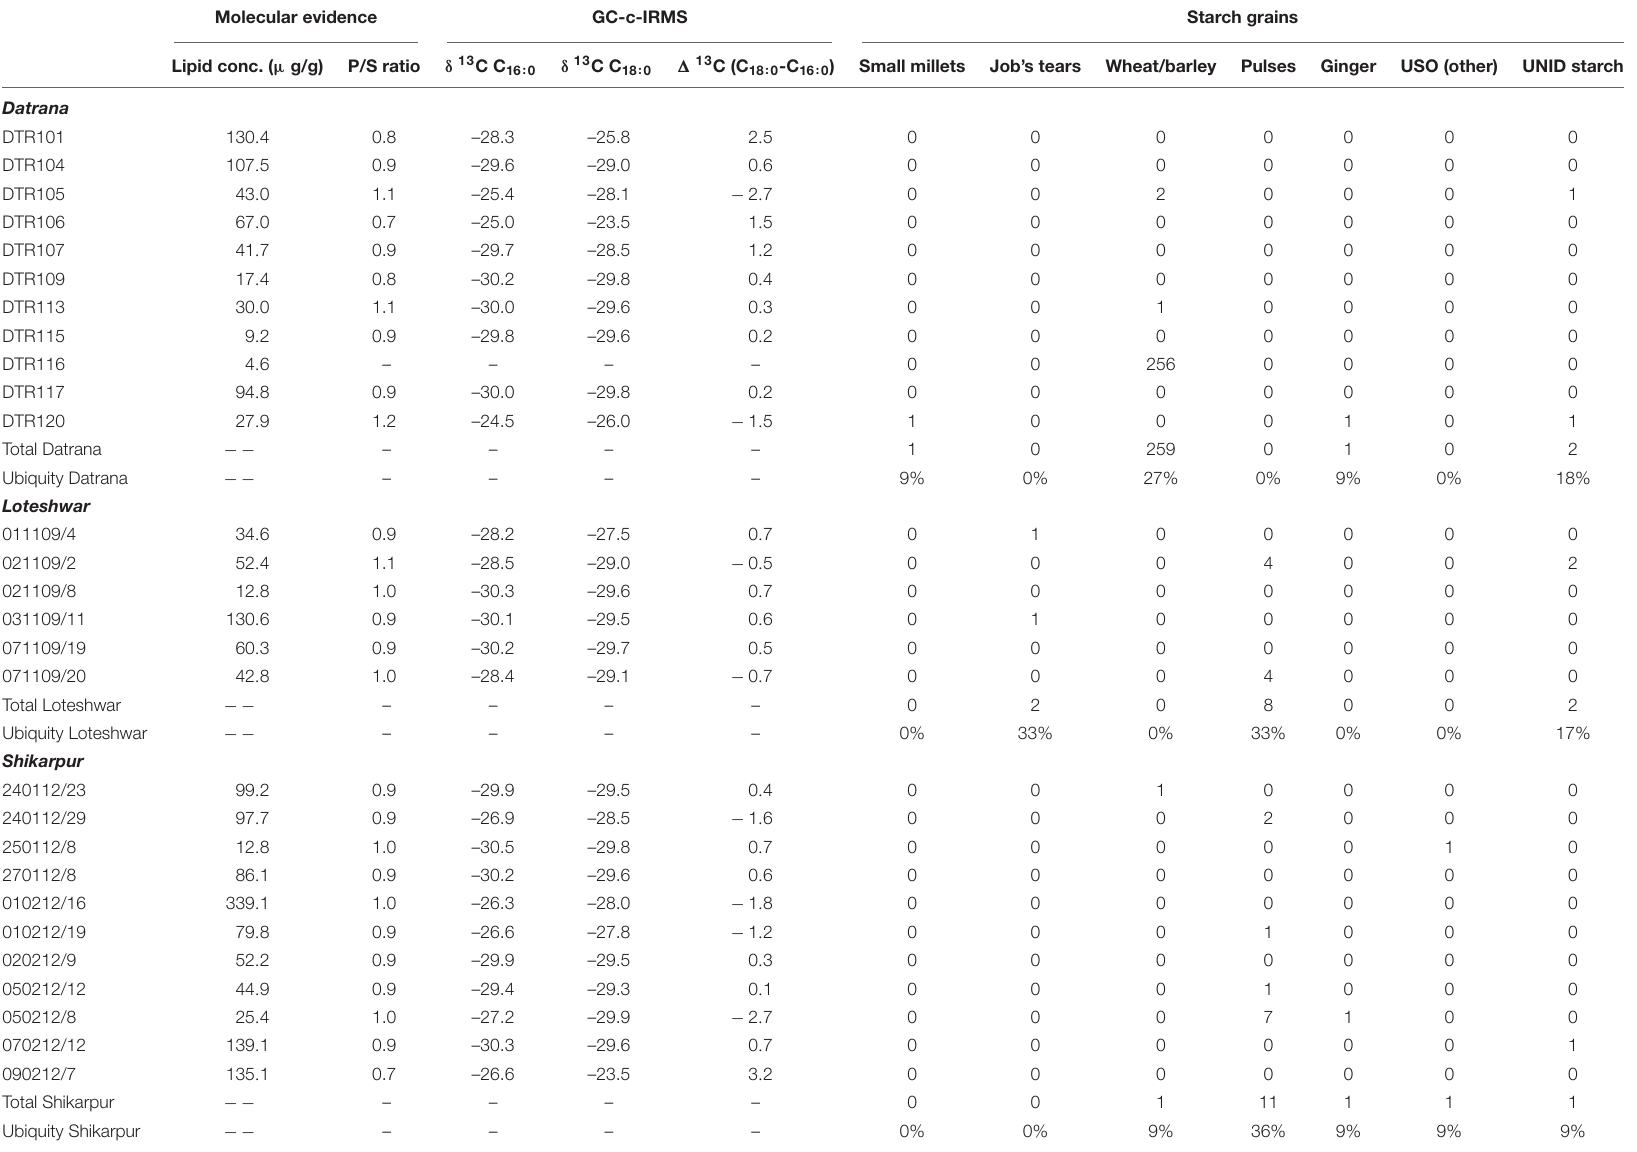
The description of the features used to taxonomically identify starch grains can be found in Table 3